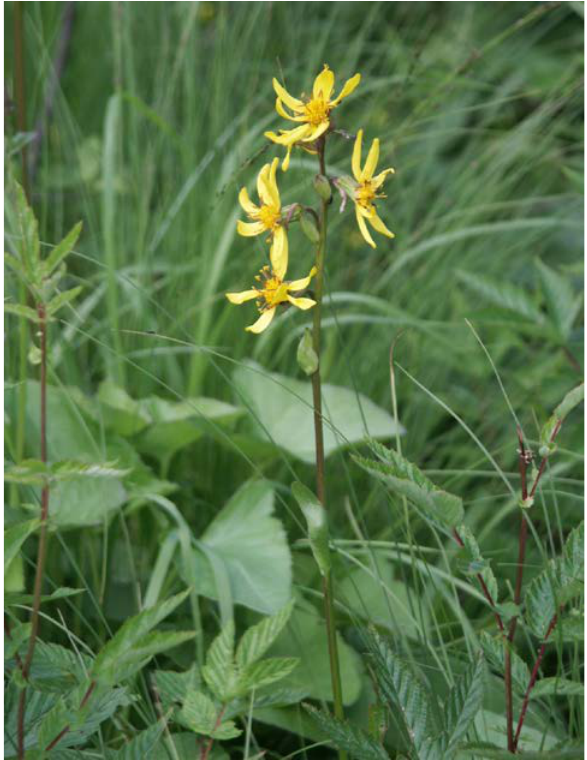
Figure 7. Ligularia sibirica in Mire 30 in 2007 (photo: Raimo